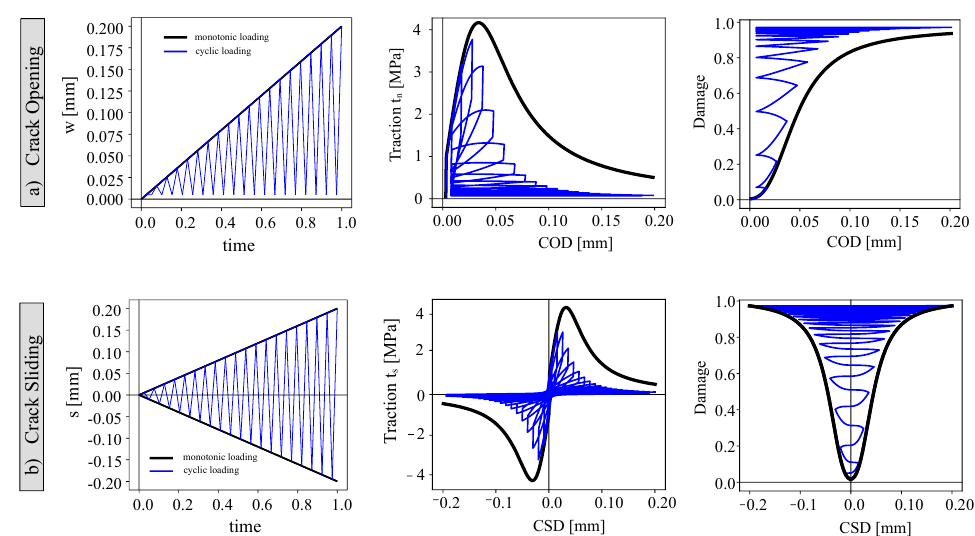
Figure 3. Characterization of the crack behavior under cyclic loading (blue lines) and monotonic loading (black lines) at the material-point level: ( a ) crack opening, ( b ) crack sliding.